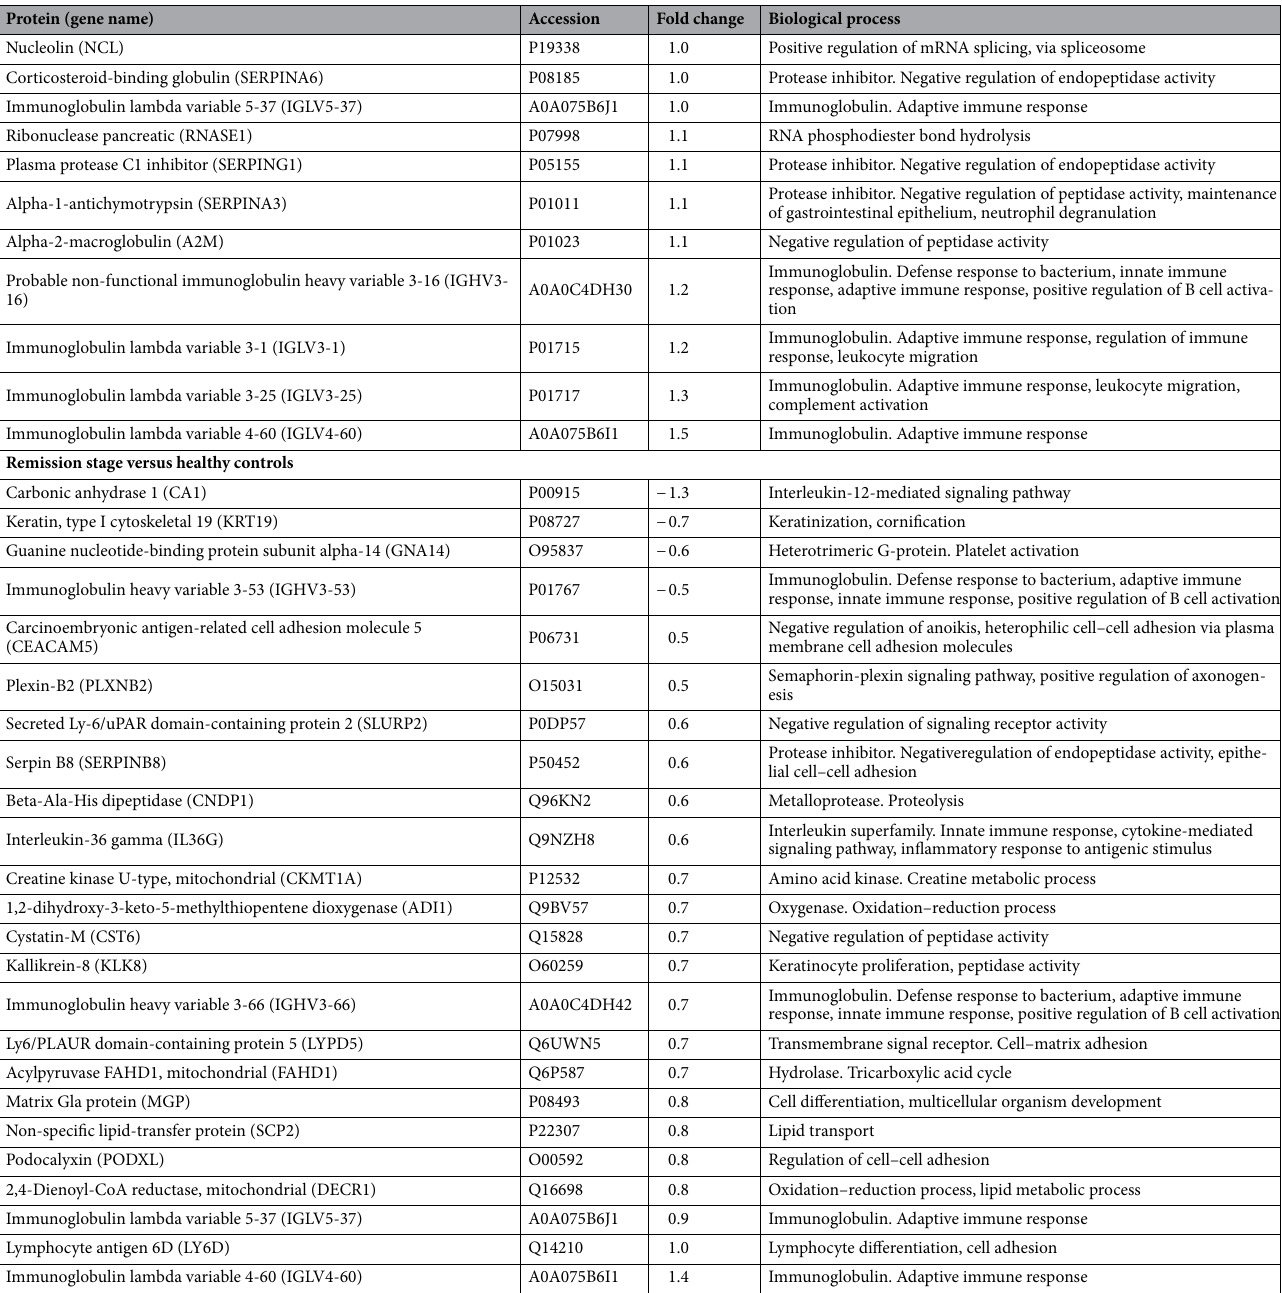
Table 1. Biological processes of differentially expressed proteins in recurrent aphthous stomatitis. Fold change (log 2 ) is a measure that describes how much an amount changes when going from an initial value to a final value. Therefore, if the initial value is A and the final value is B, the fold change is (B − A)/A or